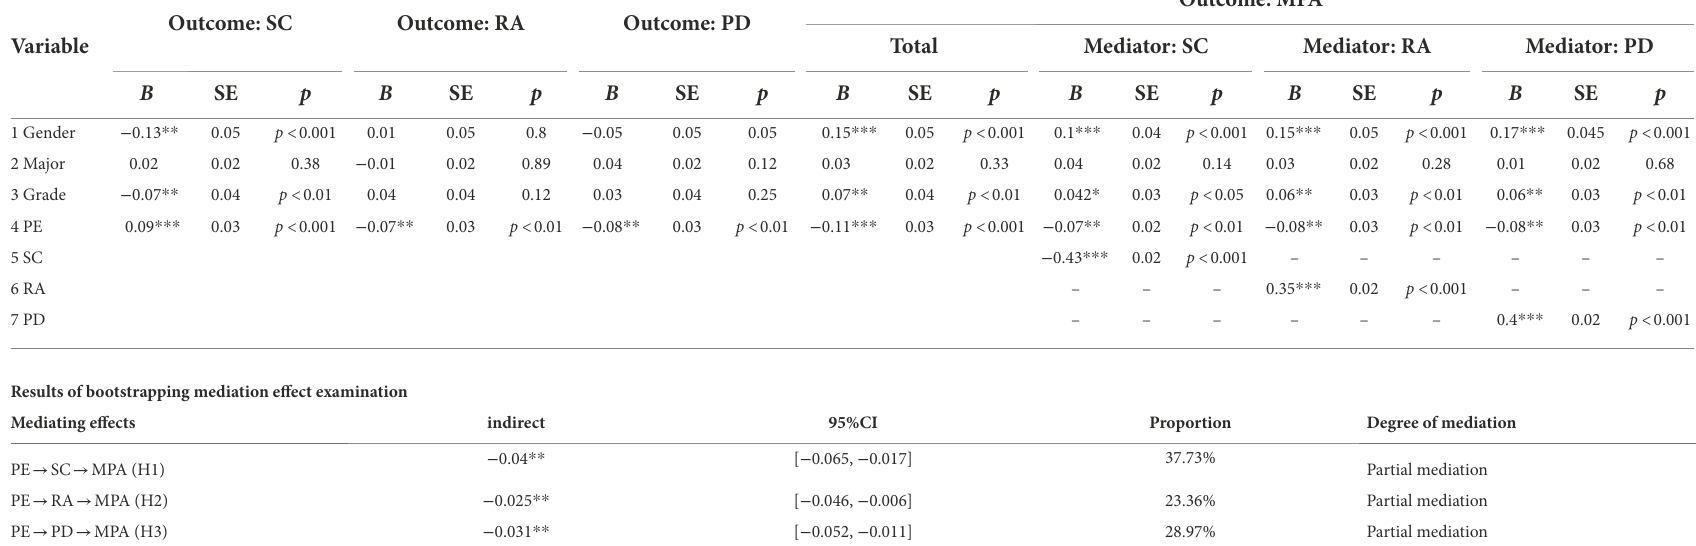
TABLE 3 Regression analysis of the simple mediation model.